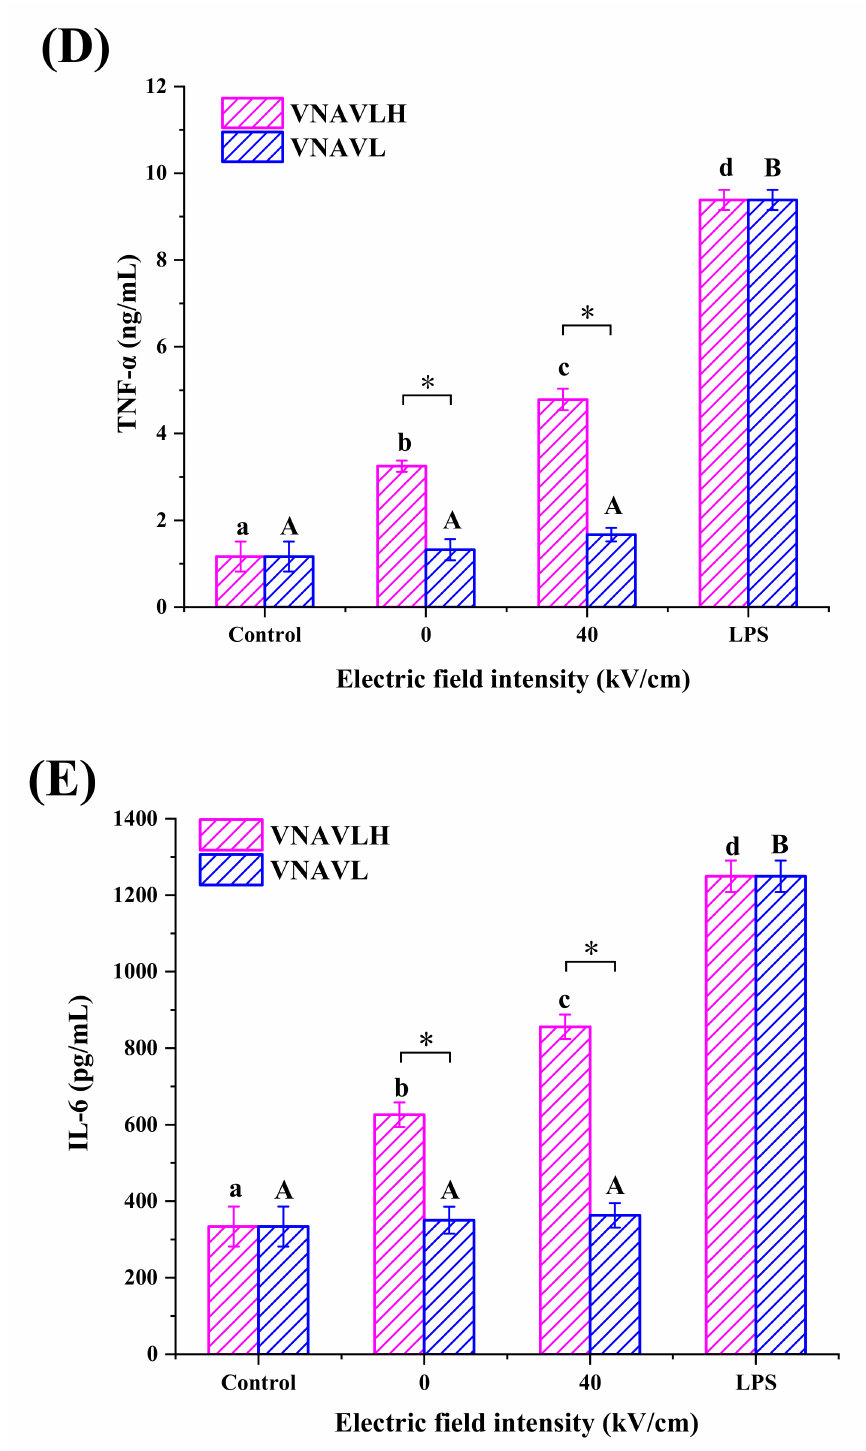
Figure 2. Effects of PEF treatment on ( A ) cell viability; ( B ) phagocytosis; ( C ) production of NO; ( D ) TNF- α ; and ( E ) IL-6 at the electric field intensities of 10, 20, 30, and 40 kV/cm, respectively. All data were expressed as mean ± standard deviation ( n = 6). The different lowercase letters represent significant differences between different electric field intensities of VNAVLH ( p < 0.05). The different capital letters represent significant differences between different electric field intensities of VNAVL ( p < 0.05). The asterisk indicates significant differences between different peptides ( p <